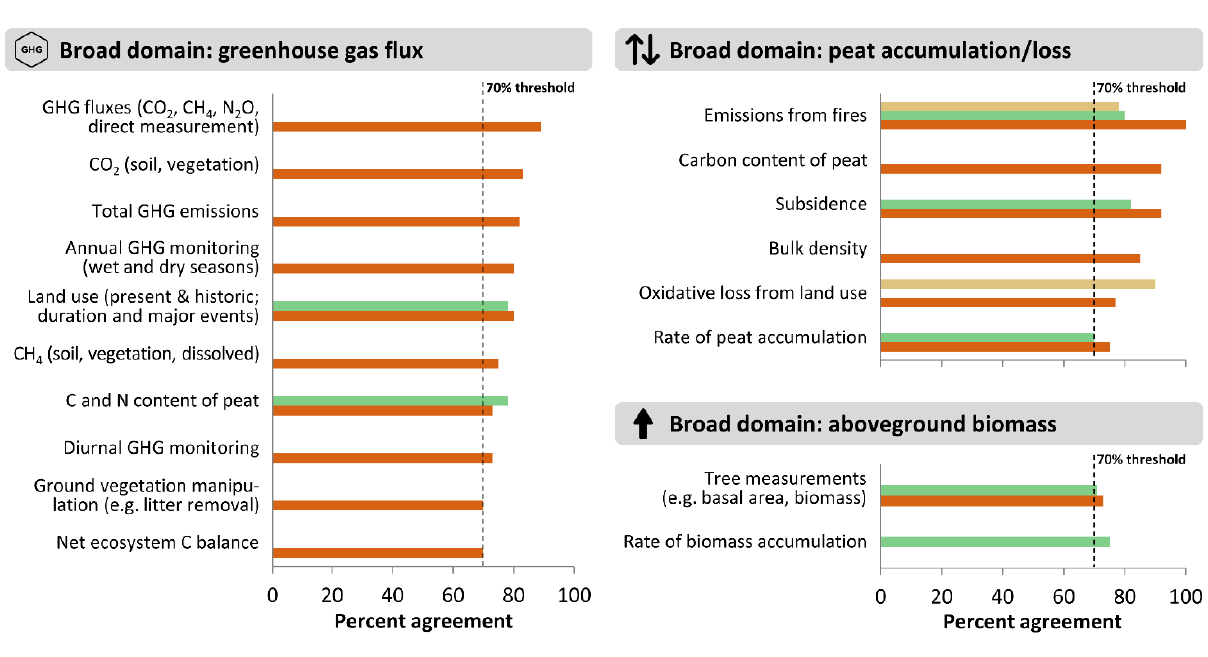
Figure 7. Climate core domain set, and the constituent target domain outcomes agreed by ≥ 70 % of respondents as potential high priorities for measurement in tropical peat swamp research or monitoring, depending on the objective or focus of the research or restoration project (based on 13 expert responses). Scores < 70 % are not